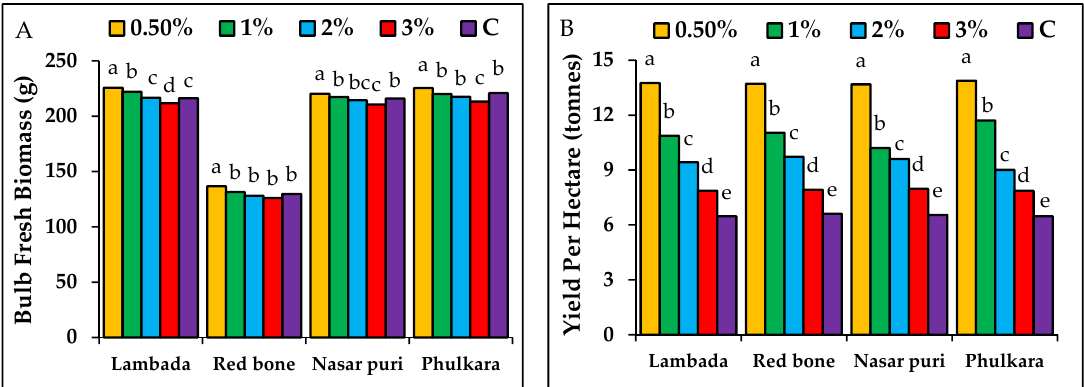
Figure 6. Bulb fresh biomass ( A ) and yield per hectare ( B ) in onion cultivars as affected by foliar application of 0 (C = control), 0.5, 1, 2, or 3% seaweed extract. Values are means of nine replicates ± standard error. Means with different letters are significantly different from each other compared by LSD at p ≤ 0.05.